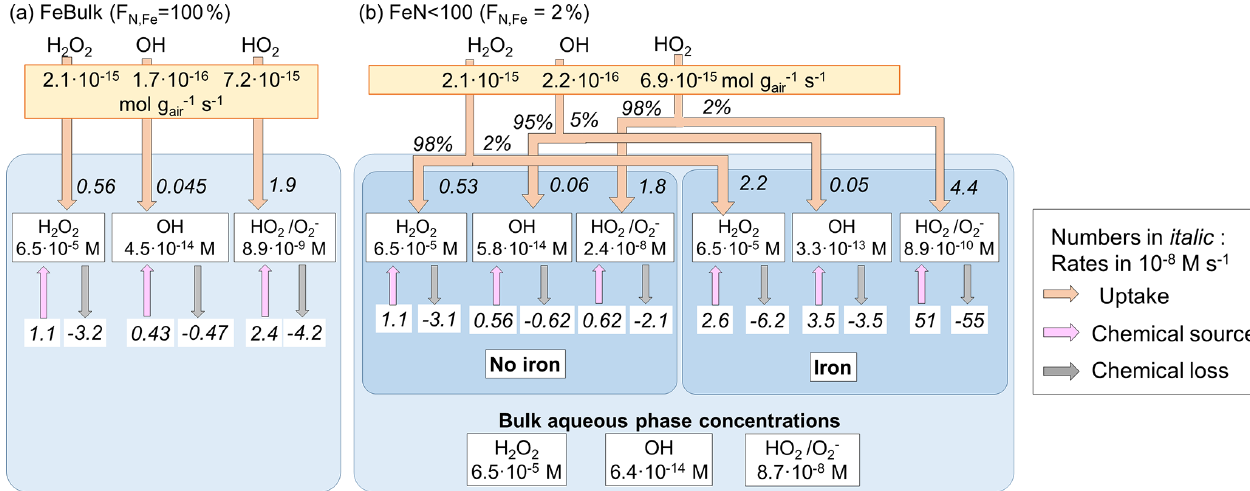
Figure 2. Multiphase scheme for cloud water showing the phase transfer and chemical source and loss rates in the aqueous phase, m Fe = 10ngm − 3 , pH = 4.5. (a) FeBulk approach. (b) FeN < 100 approach with a fraction of iron-containing droplets of F N , Fe = 2%. Num- bers below the species names are aqueous-phase concentrations (M), and chemical and phase transfer rates are shown in moles per liter per second. Net phase transfer rates near the top of the figure are expressed in gas-phase units (moles per gram of air per second); the relative contributions (%) into the iron-free and iron-containing droplets are shown next to the arrows. The bulk concentrations at the bottom of panel (b) represent the bulk concentrations weighted by the contributions of the two droplet classes to total LWC (98%:2%).